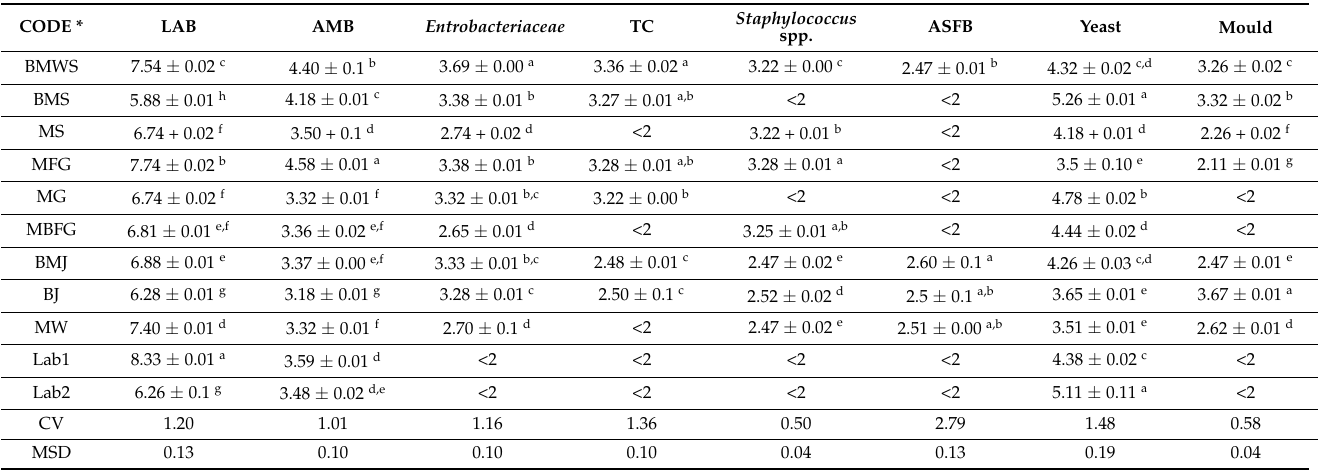
Table 3. Mean microbial count (log of cfu/g) of “Shameta” samples collected from households of lactating mothers, East Wollega Zone,